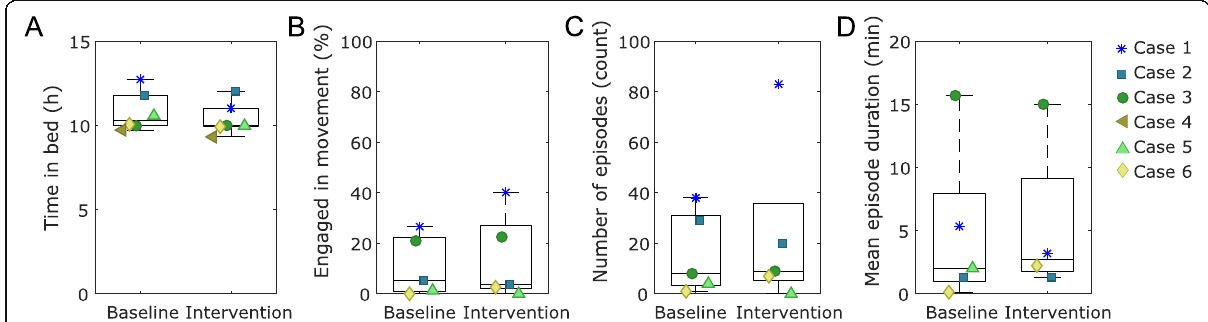
Fig. 3 Objective measures collected during the baseline and intervention night based on the video recordings ( n = 6). A. Time in bed. B. Time spent engaged in rhythmic movement calculated over the common length of baseline and intervention night. C. Number of episodes calculated over the common length of baseline and intervention night. D. Mean episode duration calculated over the common length of baseline and intervention